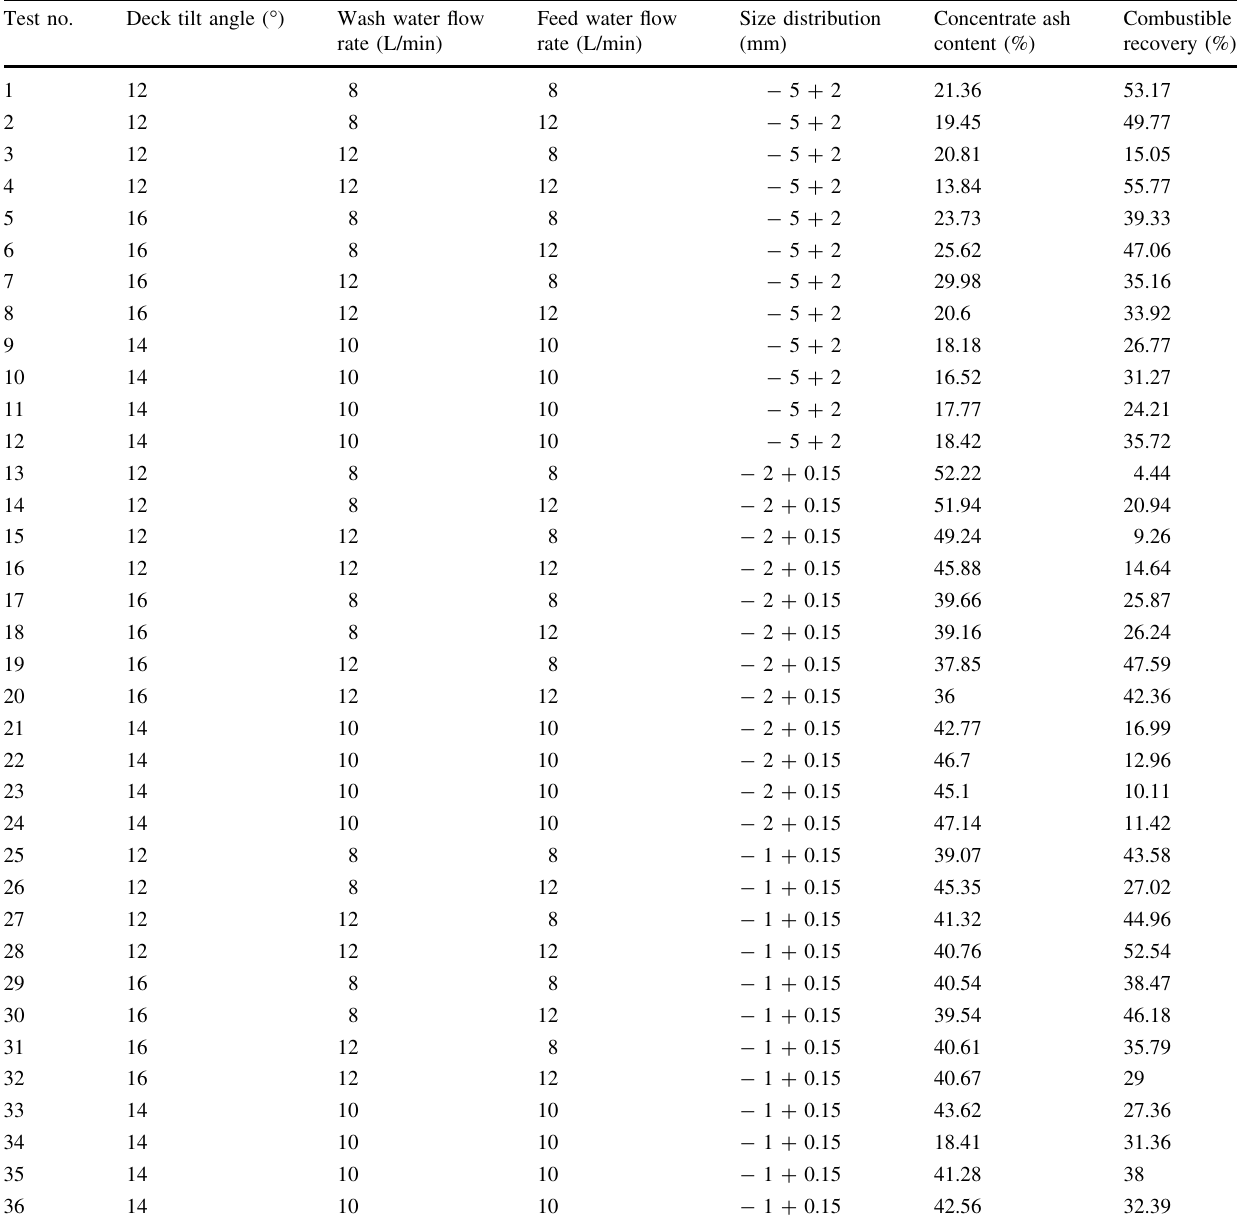
Table 4 Shaking table tests and their representative results Test